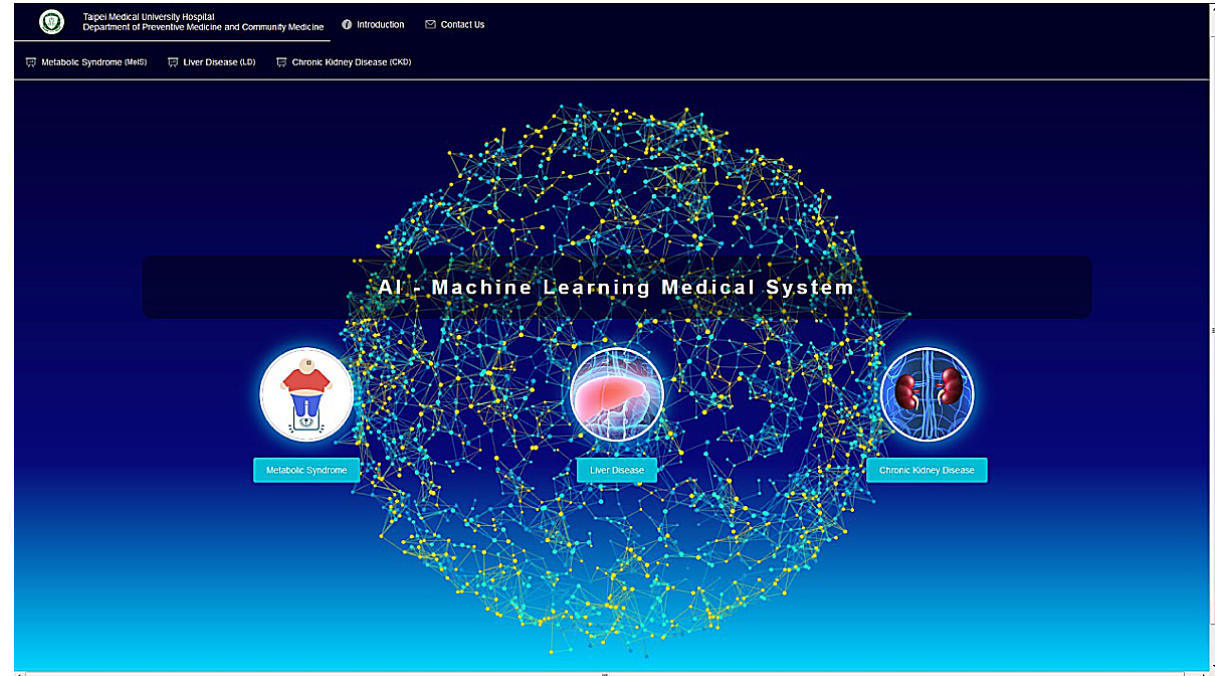
Figure 3. Home page of the machine learning health care